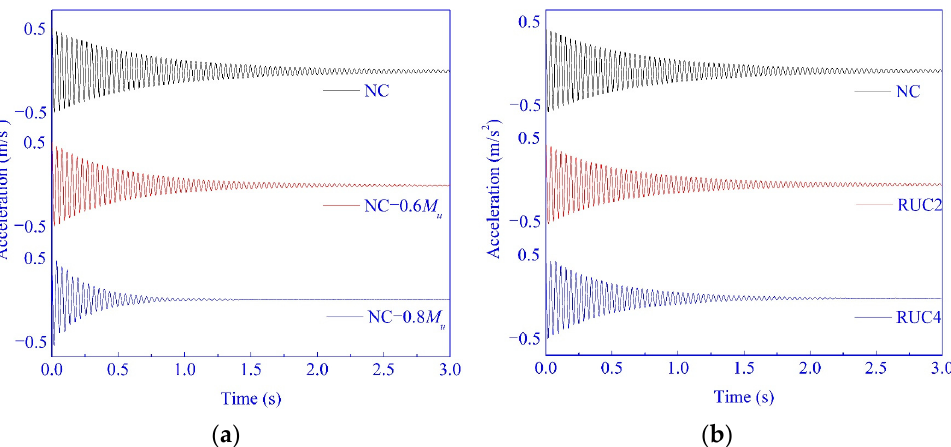
Figure 9. Time history of acceleration (with the data collected by Accelerometer 3): ( a ) The effects of rubber particle content; and ( b ) The effects of the cumulative damage.